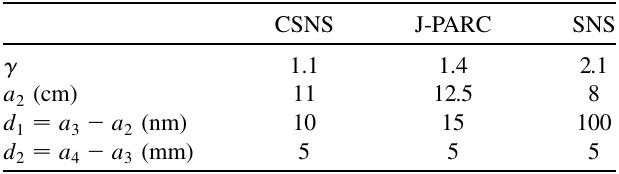
TABLE I. Main parameters of three proton rings.